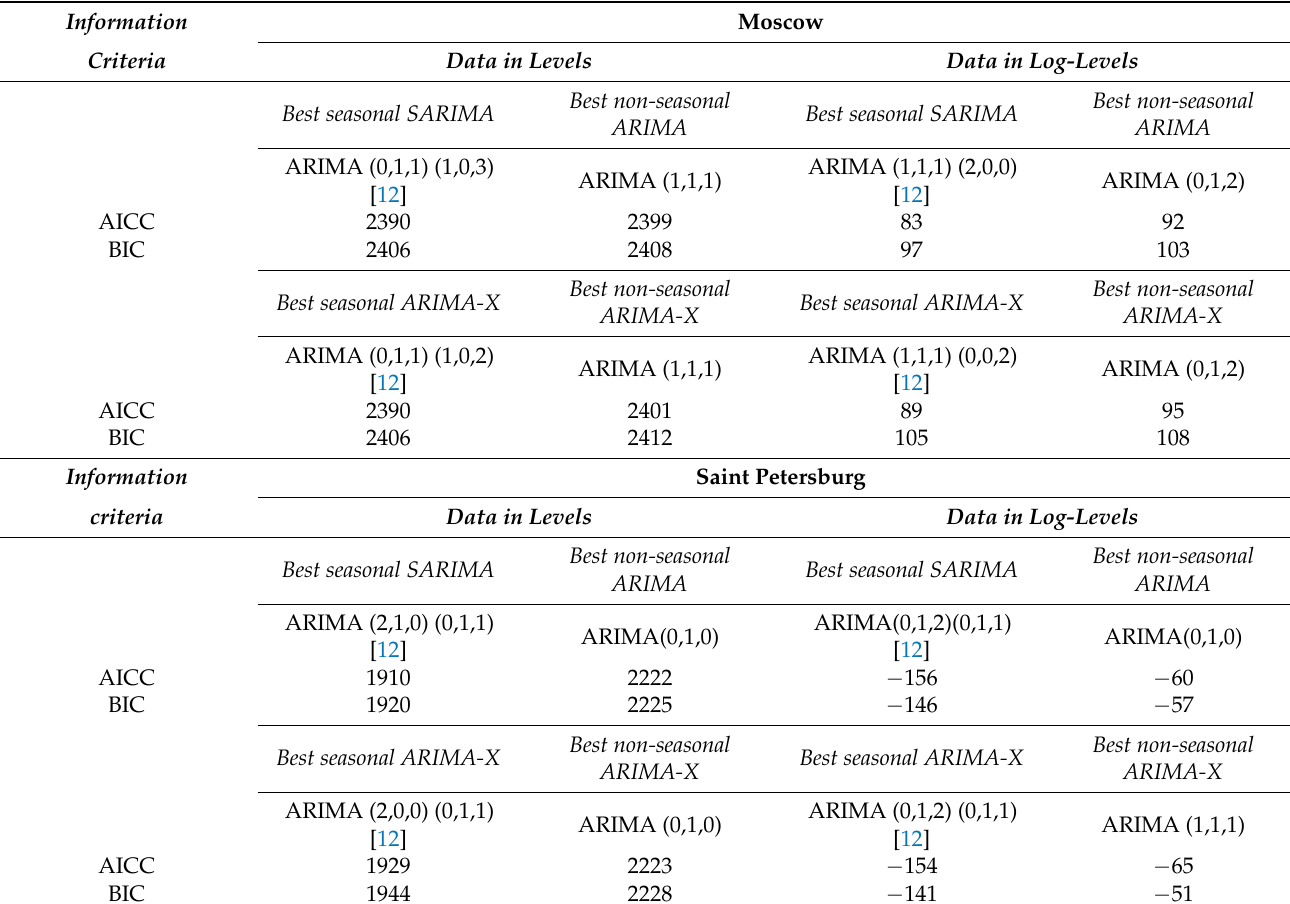
Table 4. Best seasonal and non-seasonal ARIMA models, with and without Google search data, for the Moscow and Saint Petersburg inflows data, selected using the AICC and the Khandakar and Hyndman [70] algorithm.